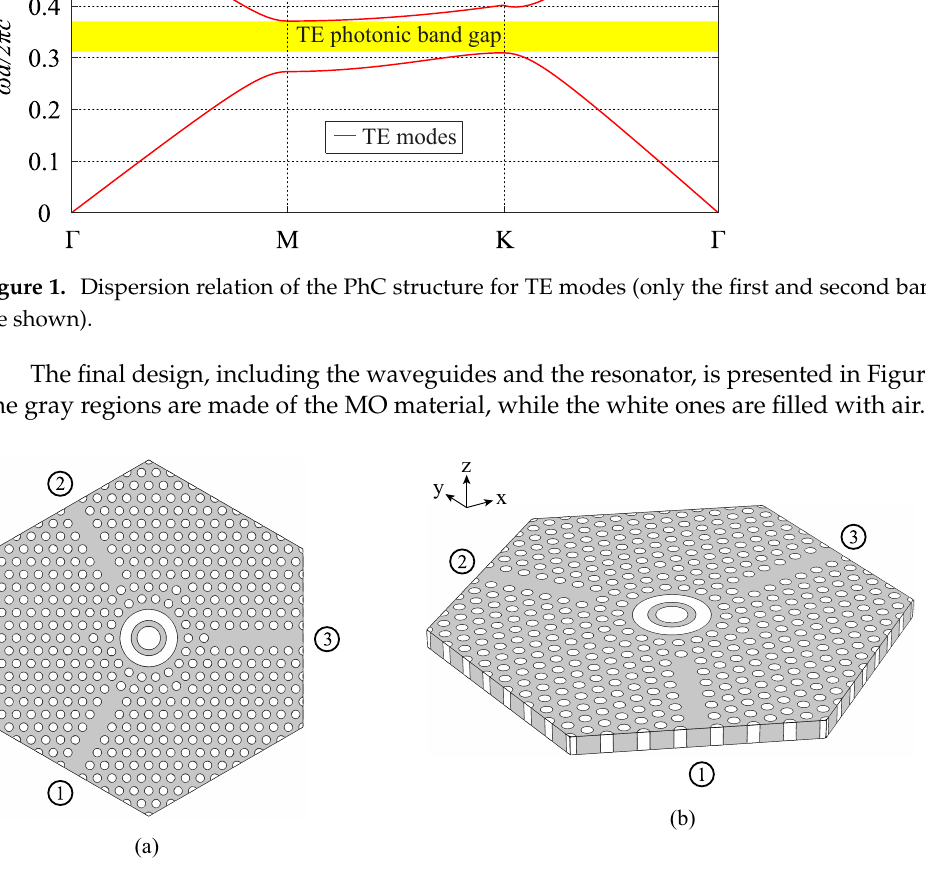
Figure 2. ( a ) Top view and ( b ) perspective view of the circulator.